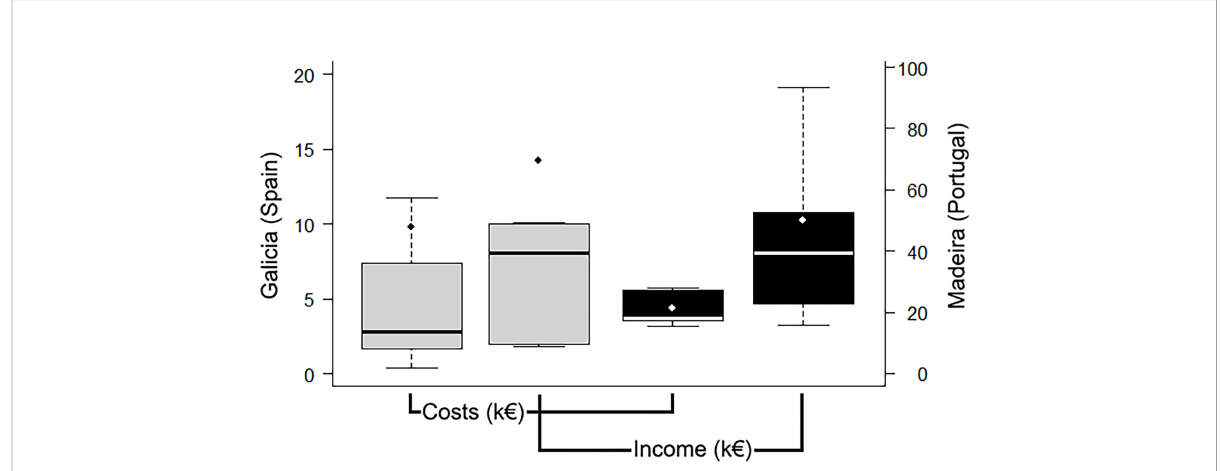
FIGURE 3 Annual expenses and income of companies engaged in commercial MRF in Spain (Galicia, in grey; left y-axis) and Portugal (Madeira archipelago, in black; right y-axis). The top and bottom sides of the boxes correspond to the fi rst and third quartiles of the values, the vertical lines extend up to 1.5 times the interquartile range, the median is indicated with a horizontal line, and the mean with a black dot. Outliers are not shown for visualization